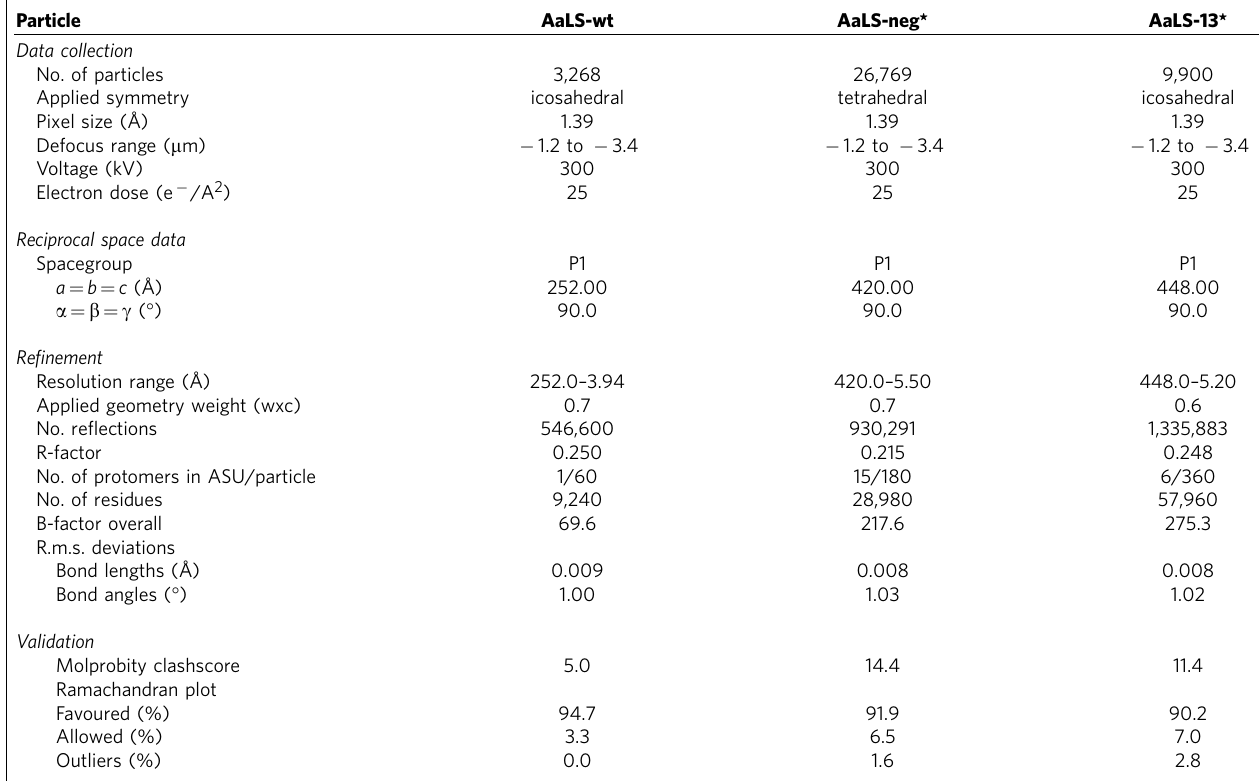
Table 1 | Refinement and validation statistics for the atomic models of AaLS-wt, AaLS-neg and AaLS-13. Particle AaLS-wt Data collection No. of